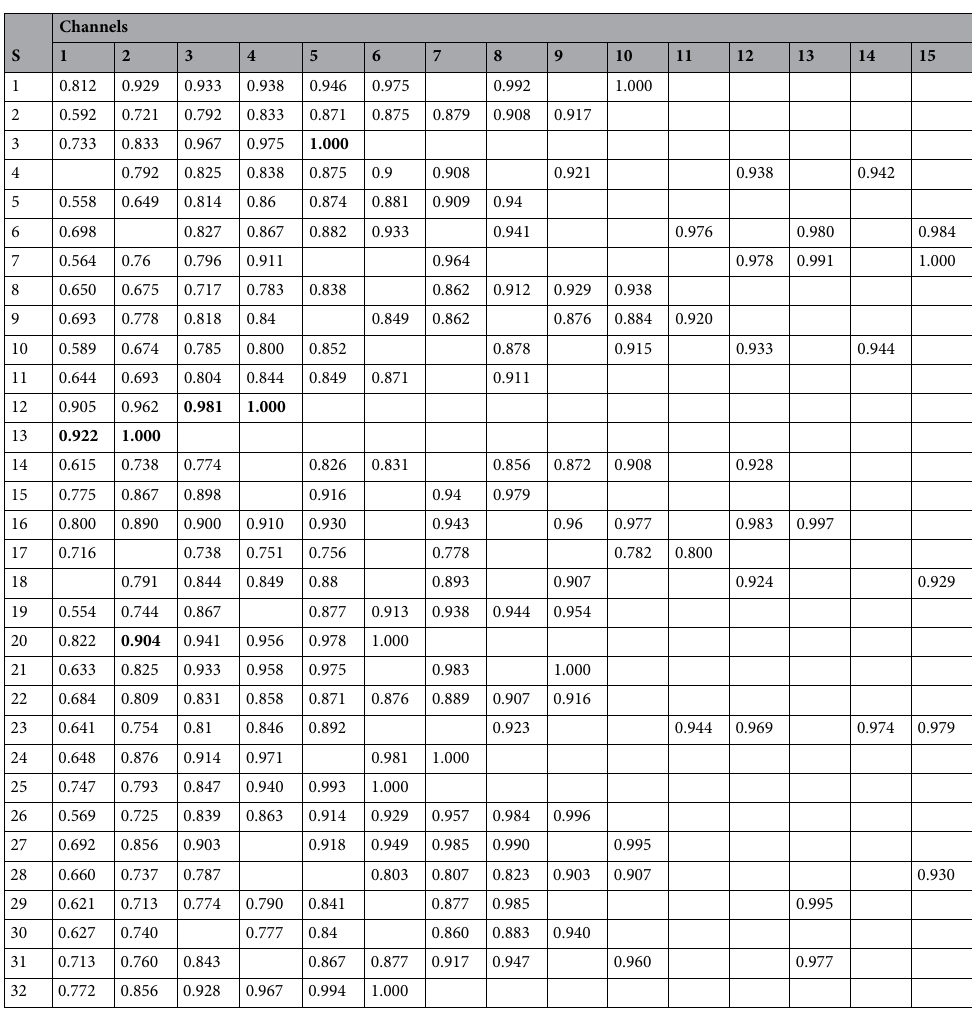
Table 4. Low vs high valence classification accuracies obtained with EEGNet. Accuracies obtained in the Pareto-front for the first 1-15 channels selected by NSGA-II. The subjects with the highest accuracies per channel set are indicated in bold.